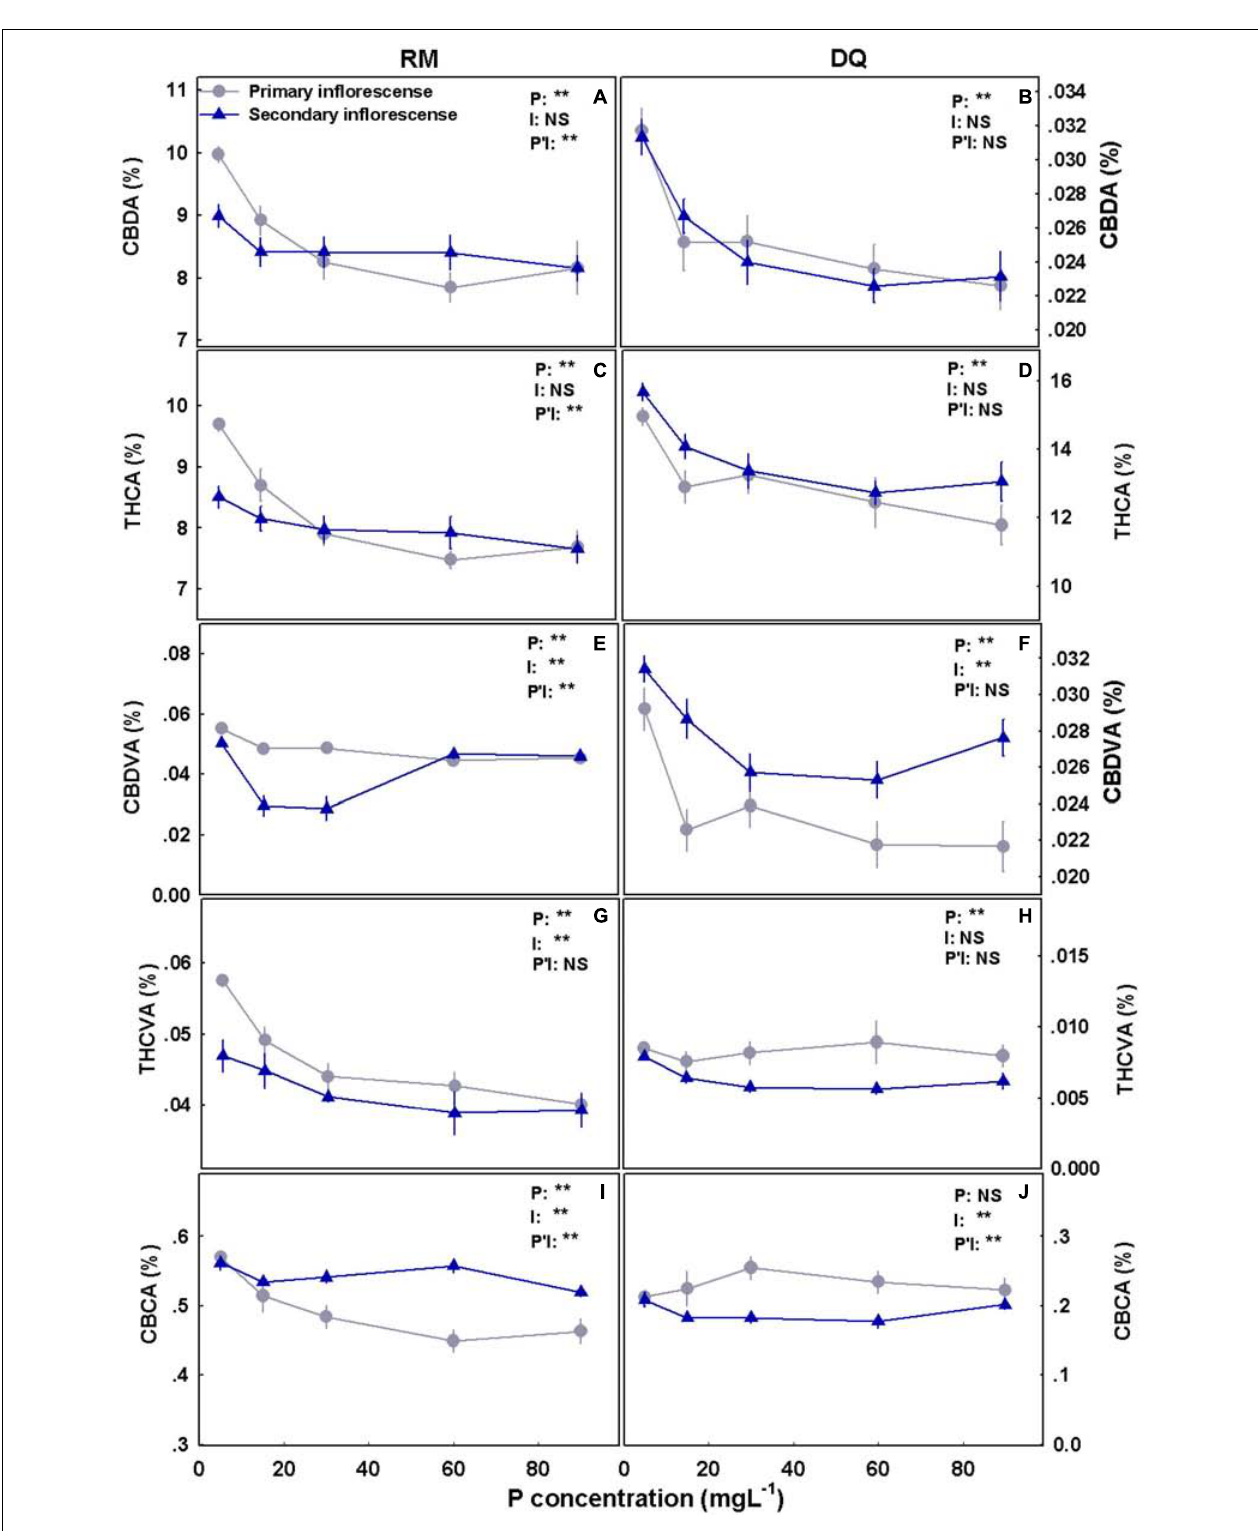
FIGURE 9 | Effect of P application on cannabinoid concentrations in primary and secondary apical inflorescences in medical cannabis plants in two cultivars, RM and DQ. Cannabidiolic acid (A,B) , (cid:49) 9 -tetrahydrocannabinolic acid (C,D) , cannabidivarinic acid (E,F) , (cid:49) 9 -tetrahydrocannabivarinic acid (G,H) , and cannabichromenic acid (I,J) . The presented data are averages ± SD ( n = 6). Results of two-way ANOVA indicated as ** P < 0.05, F -test; NS, not significant P > 0.05, F -test. In the ANOVA results, P*I, the interaction between P and the inflorescence location.